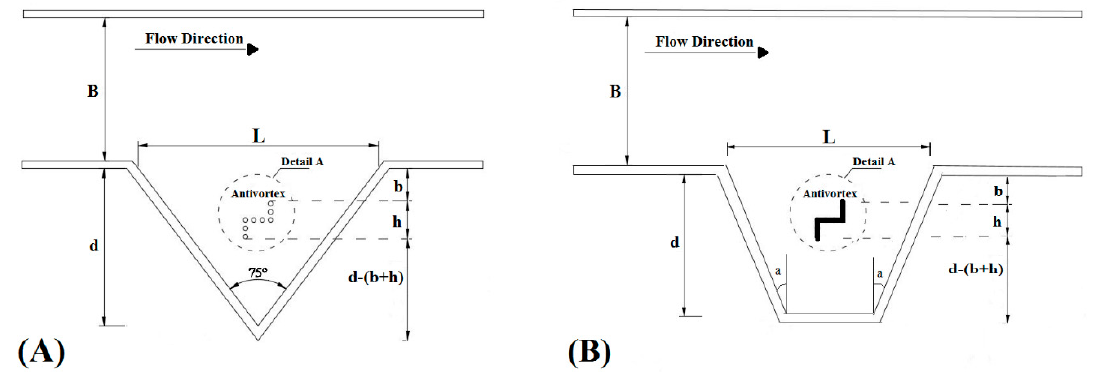
Figure 21. View of the best model of the antivortex inside the labyrinth side weir. ( A ): Present study; ( B ): Emiroglu et al. [18].